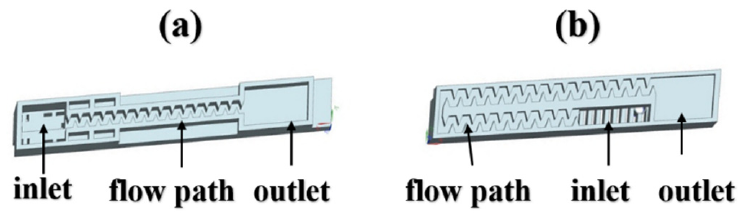
Figure 2. Schematic of flat emitters were manufactured from Israel ( a ) and China ( b ). Water quality is a direct factor that induces emitter clogging, and Bucks divided the types of emitter clogging into physical, chemical, and biological [21]. Since the first